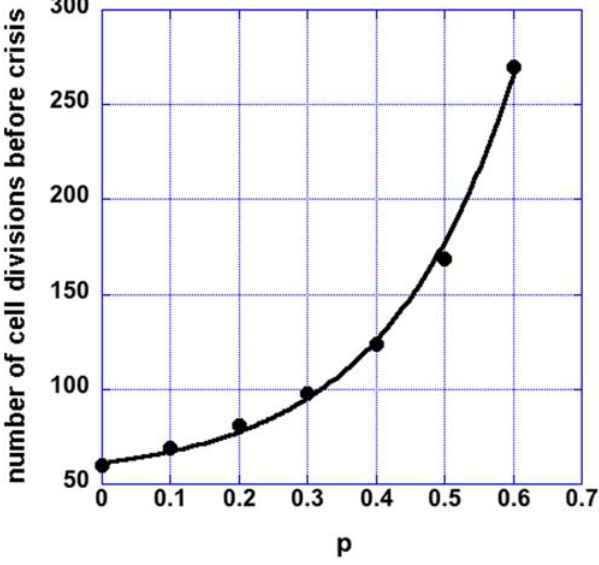
Here the normalized telomerase concentration p is relative to the telomerase-telomere fraction p 0 = 50/92 at which the PP is infinite, i.e. p = (50/92)p. The dependence of the PP is well approximated by an exponential in this parameter range: